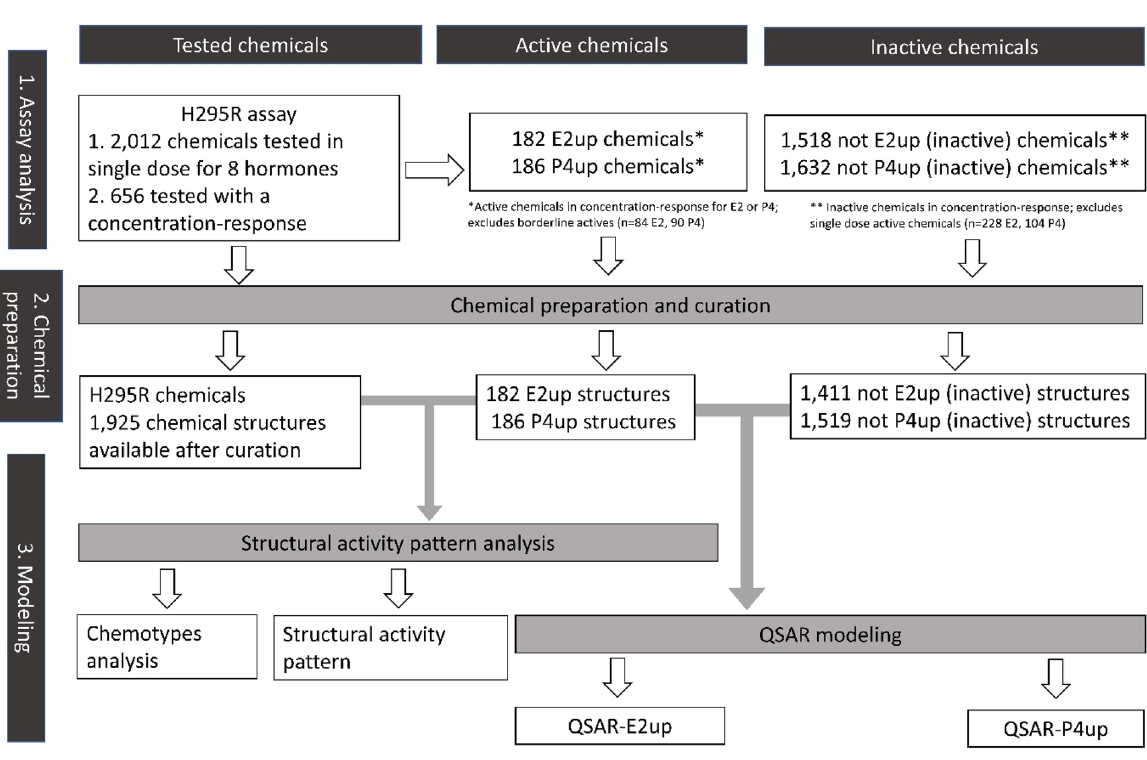
Figure 2. Workflow of the